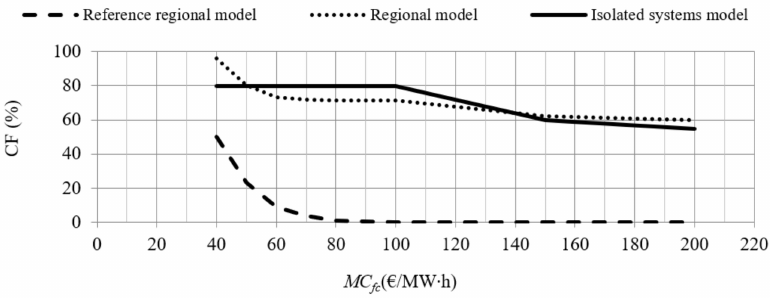
Figure 5. The capacity factor (CF) of a newly installed FC in the Croatian power system for different MC fc assessed for model outcomes.